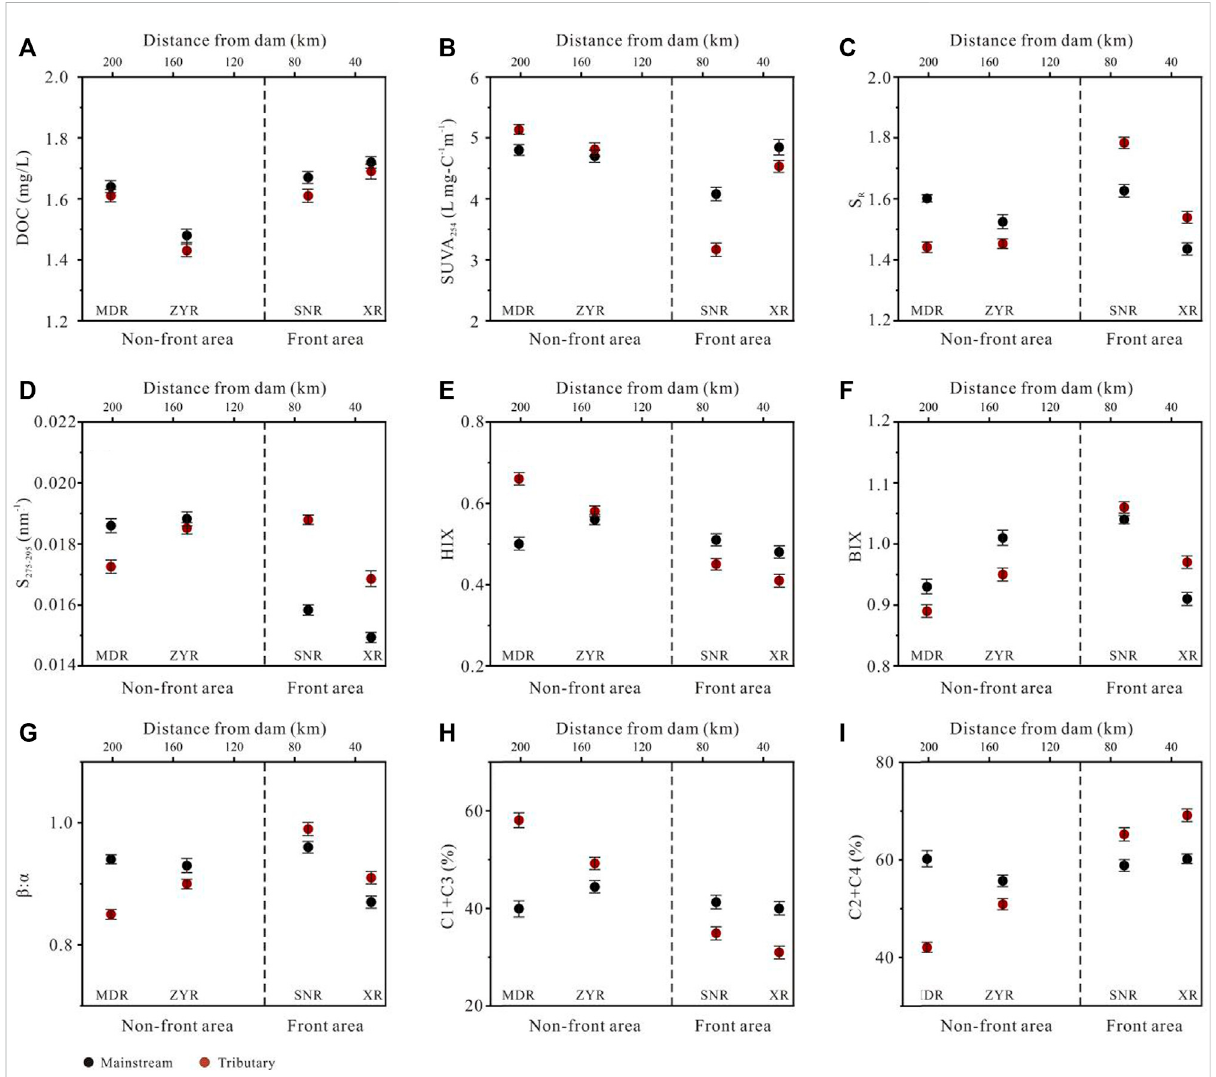
FIGURE 2 Bulk and optical properties variation of DOM. (A) DOC, (B) SUVA254, (C) SR, (D) S275-295, (E) HIX, (F) BIX, (G) β : α , (H) C1+C3, (I)